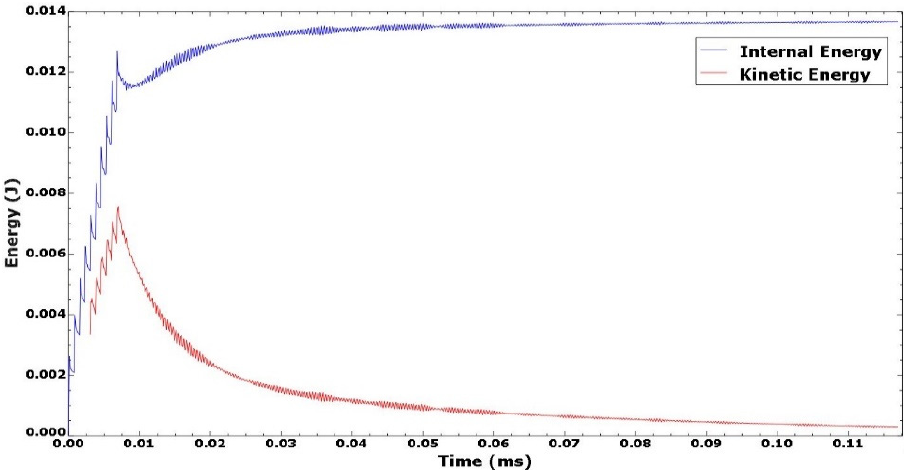
Figure 7. System dynamic response and energy field profile.